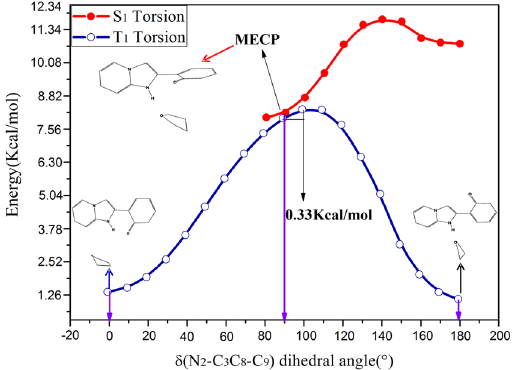
Figure 14. Constructed the potential energy curves of the HPIP: red line: the energies of different structures versus the dihedral angles δ (N 2 -C 3 C 8 -C 9 ) in the S 1 state; blue line: the energies of different structures versus the dihedral angles δ (N 2 -C 3 C 8 -C 9 ) in the T 1 state. The numerical value in the graph stands for the energy barrier of the reaction. The MECP and the corresponding structure have been shown.